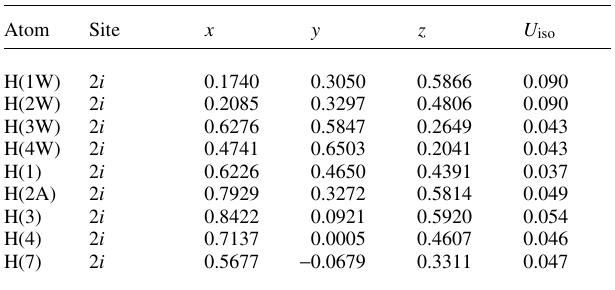
Table 2. Atomic coordinates and displacement parameters (in Å 2 )